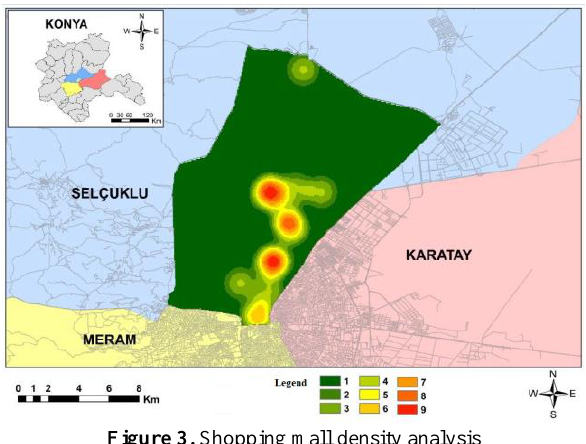
Figure 3. Shopping mall density analysis